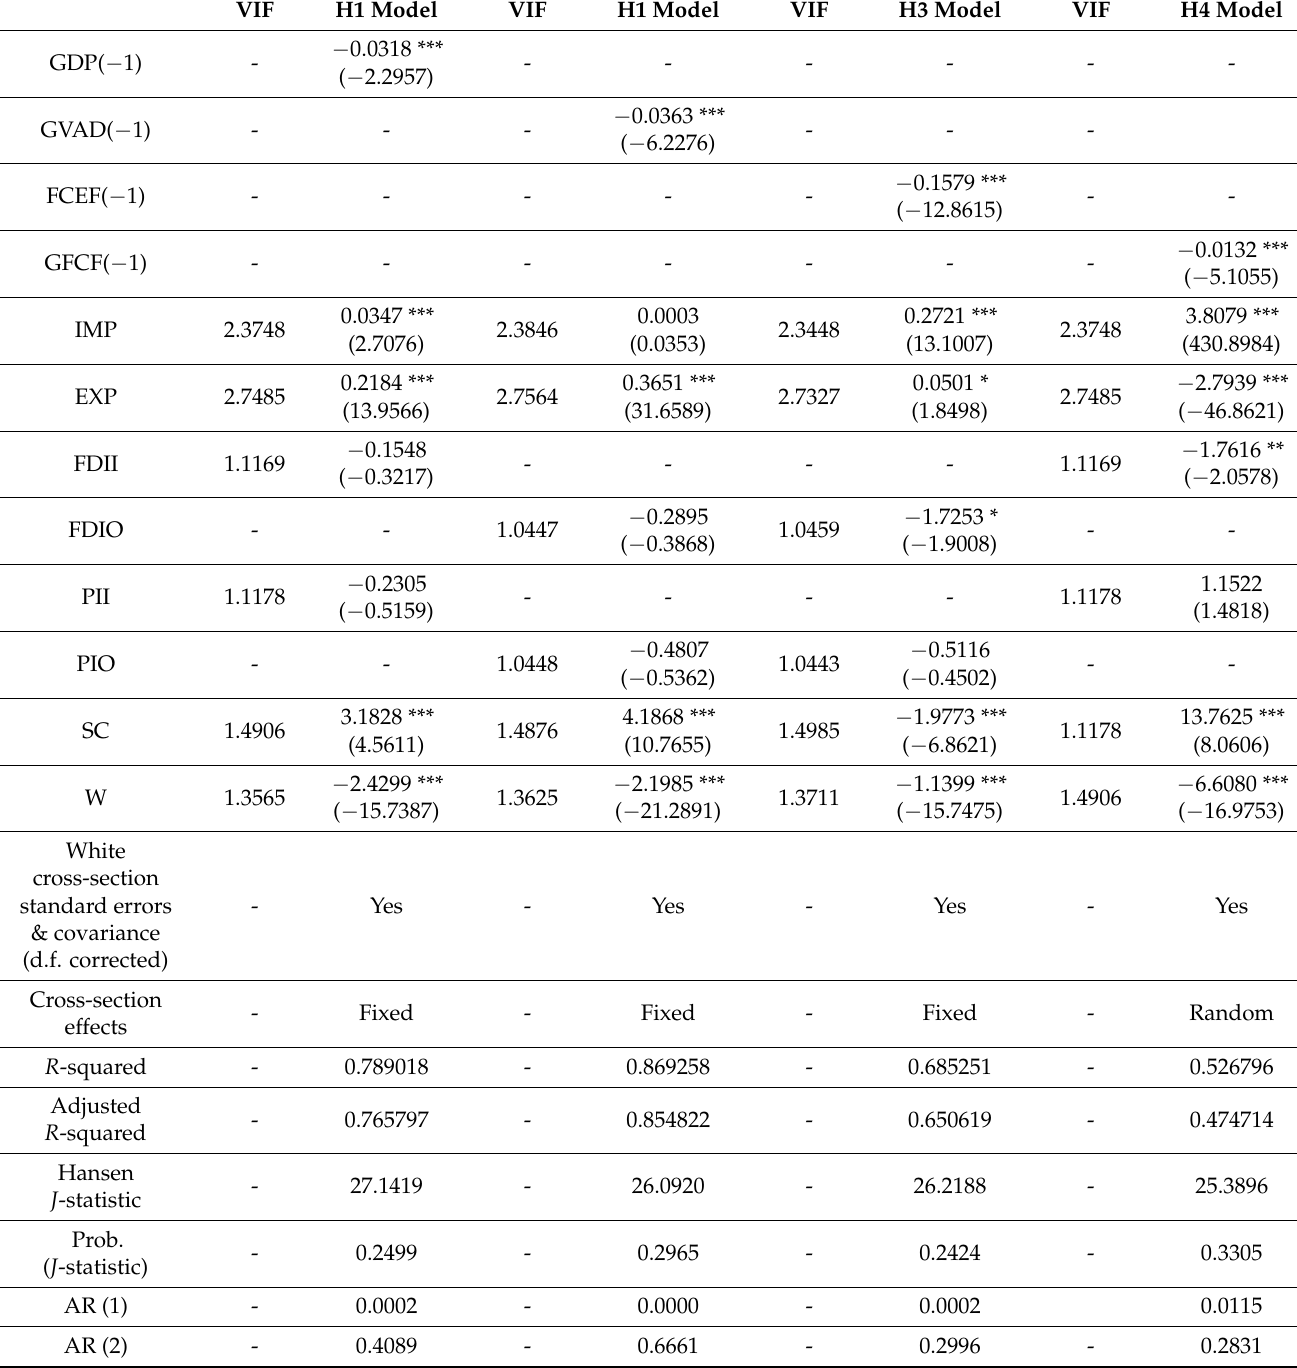
Table 4. Econometric models for the dependent variables GDP, GVAD, FCEF, and